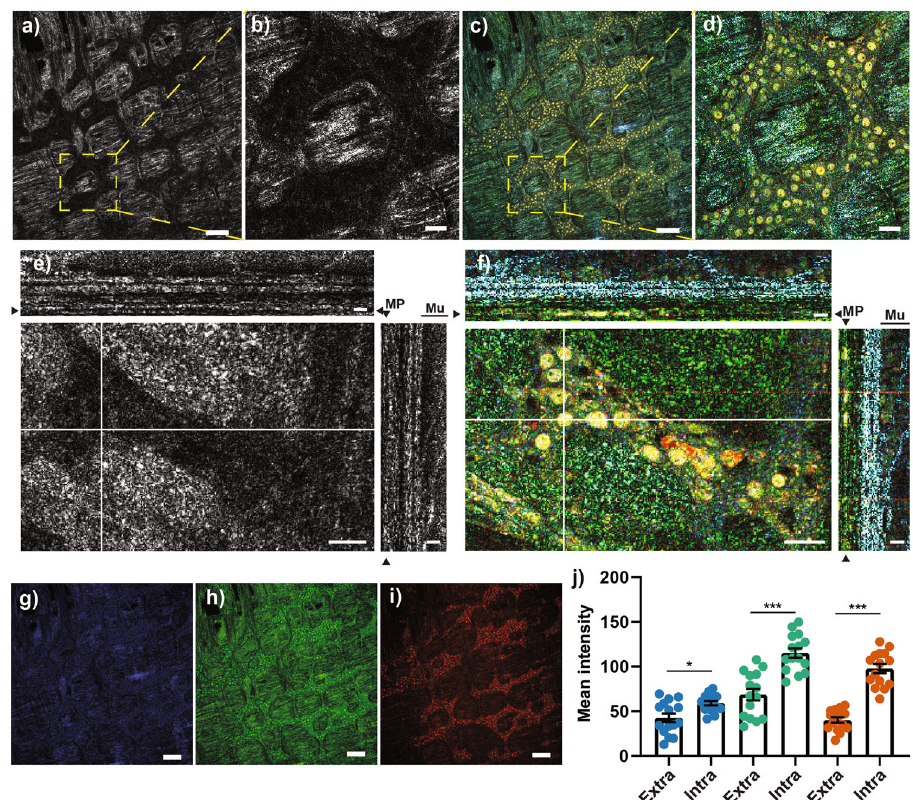
Fig. 2 Comparison of FFOCT and D-FFOCT imaging of the myenteric plexus in the mouse colon. a – d Micrograph of the myenteric plexus region in FFOCT ( a , b ) or D-FFOCT ( c , d ). b and d represent an enlargement of the dotted area in ( a ) and ( c ), respectively. e , f Orthogonal view of different planes (x/y; x/z and y/z) of FFOCT ( e ) and D-FFOCT ( f ) z-stack images (60 images). Arrows head point out the position of “ en face image ” in the orthogonal view. g – i The D-FFOCT micrograph in ( c ) is a RGB-coded image in which the blue channel ( g ) represents the low frequencies [0 – 0.6 hertz], the green channel ( h ) corresponds to medium frequencies [0.6 – 5.4 hertz] and the red channel ( i ) to high frequencies [5.4 – 25 hertz]. j The mean intensity of low (blue), medium (bluish green), or high (vermillion) frequencies was determined in intra- and extra-ganglionic regions of the myenteric plexus. Three animals were used to determine the mean intensity + / − SEM and fi ve independent regions were analyzed per animal. Statistic: two-tailed Mann and Whitney t-test. * p < 0.05; *** p < 0.001. Scale bar: a , c , g – i , 125 µ m; b , d , 30 µ m; e – f , x/y 30 µ m, x/z and y/z 12 µ m. MP myenteric plexus, Mu